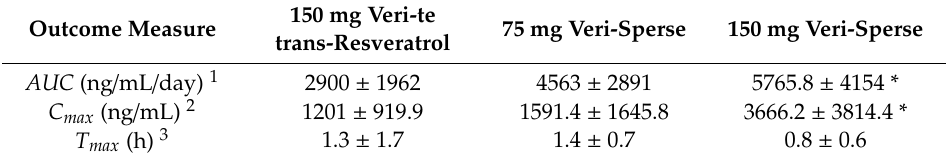
Table 1. Trans-resveratrol-sulfate absorption data.